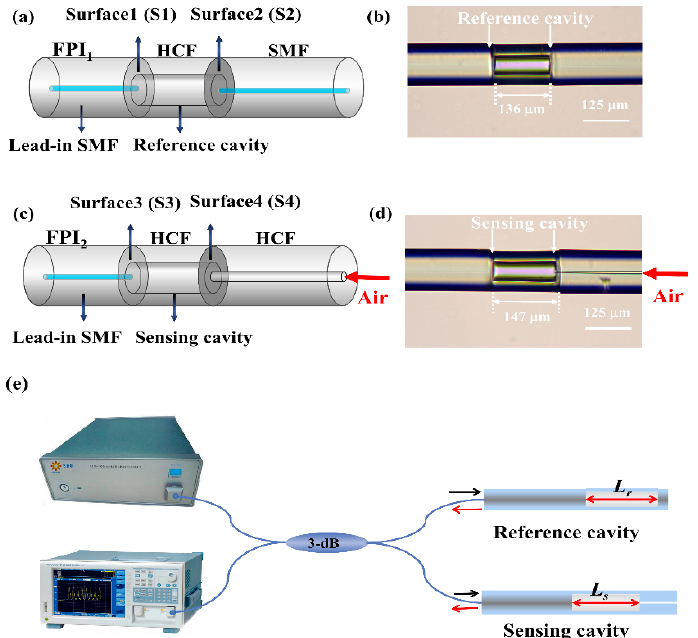
Figure 1. ( a , c ) Schematic of the two FPIs. ( b , d ) The microscope images of the two FPIs. ( e ) Schematic diagram of experimental setup with paralleled FPIs.